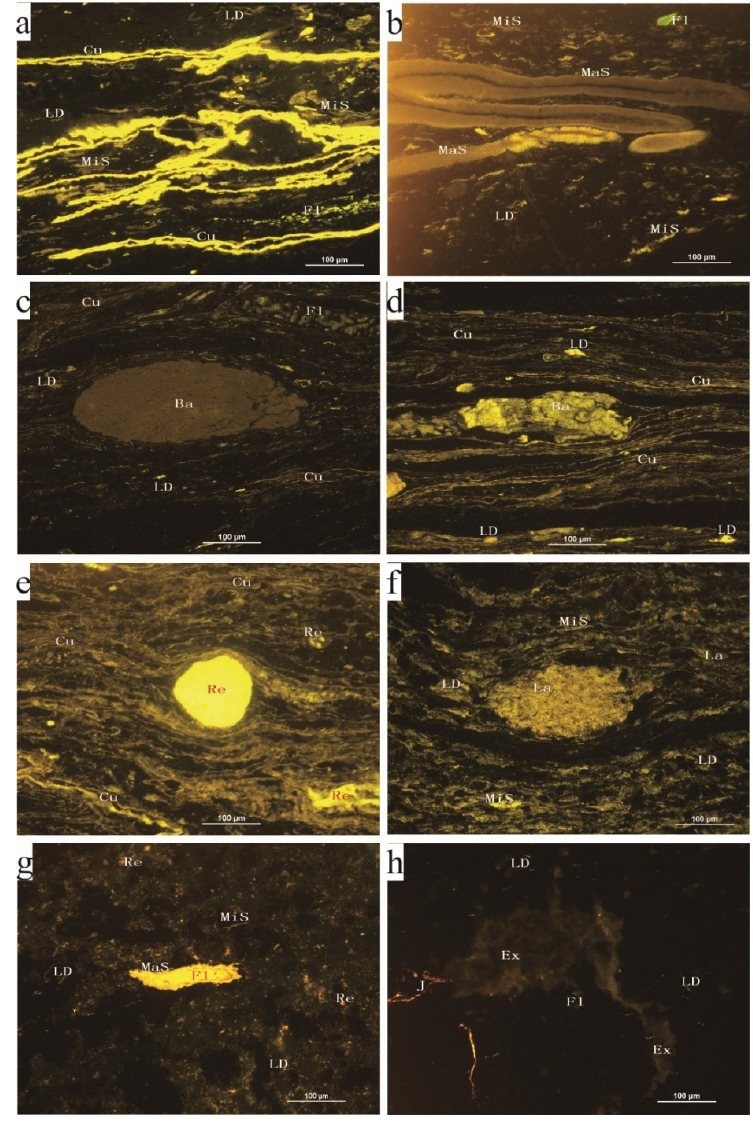
Figure 4. Photomicrographs of representative liptinite with fluorescence-inducing blue light in the Middle Jurassic coals from the southern Junggar Coalfield. ( a ) Sample CL4. Cutinite (Cu) has a parallel distribution within collinite (C). Microsporophyte (MiS), liptodetrinite (LD), and sparse flourinite (Fl) exist. ( b ) Sample CT1. Macrosporinite (MaS), microsporophyte (MiS), and liptodetrinite (LD) have a parallel distribution. The fluorescent color of LD turns a sepia color. ( c ) Sample WQ1. Barkinite (Ba) is distributed with lenticel, with a length of ~400 μ m and a width of ~125 μ m. Flourinite (Fl) has a relatively centralized structure and liptodetrinite (LD) presents with a promiscuous structure. ( d ) Sample WQ1. Barkinite (Ba) is distributed within band cutinite (Cu). Liptodetrinite (LD) originating from Ba is distributed sporadically. ( e ) Sample WQ2. Cutinite (Cu) has a parallel distribution within collinite (C). Resinite (Re) has globular shape with a diameter of ~100 μ m and part of it shows irregular graininess; ( f ) Sample HX1. Lamalginite (La), microsporophyte (MiS), and liptodetrinite (LD) have a parallel distribution within collinite (C). La presents in an elliptical structure with a length of ~220 μ m and a width of ~120 μ m. ( g ) Sample UT1. Fluorinite (Fl) fills the cellular cavity. ( h ) Sample CL1. Exsudatinite (Ex) is distributed irregularly. The fluorescence in pores and fissures comes from gelatin (J).